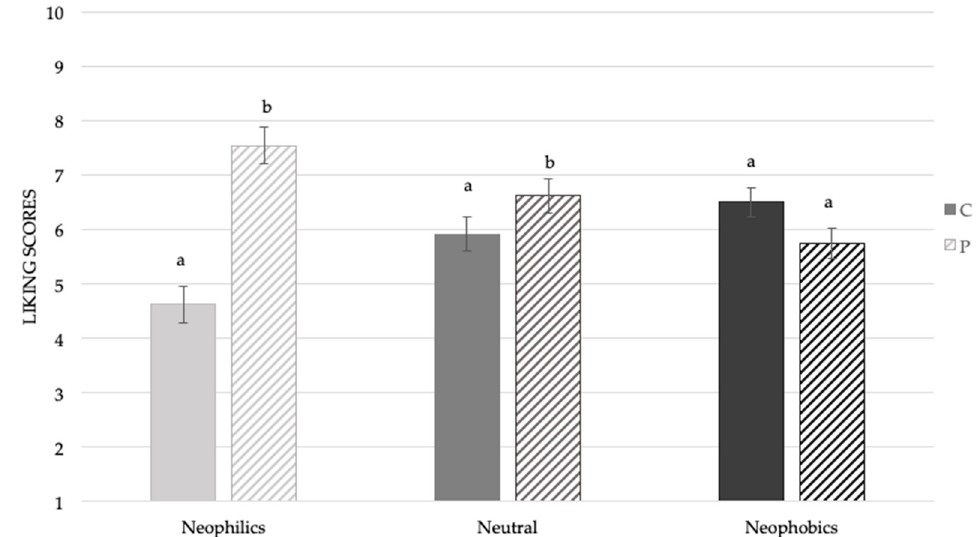
Figure 2. Mean liking scores ± SEM by samples according to food technology neophobia levels. Different letters indicate significant differences according to a post-hoc test for each sample.